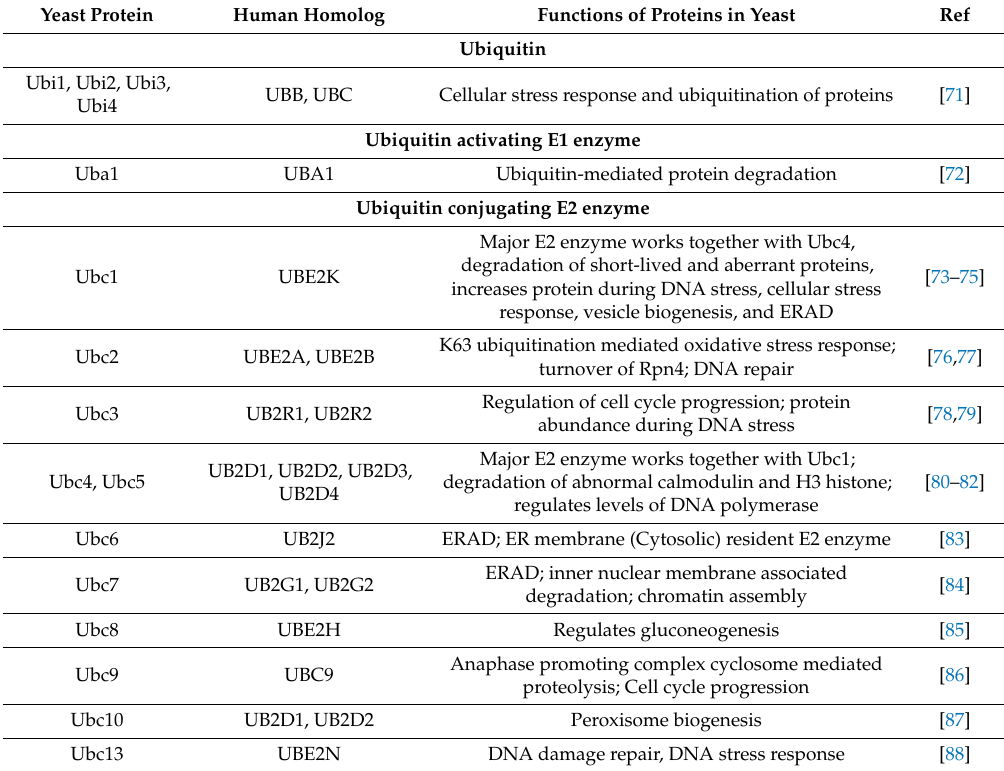
Table 2. Yeast ubiquitins, E1 activating enzymes, and E2 conjugating enzymes conserved in humans that are involved in polyubiquitylation of substrate protein.